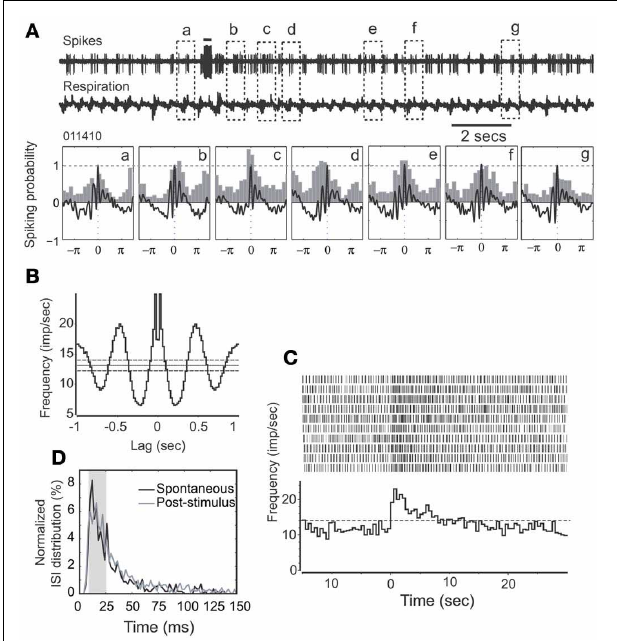
FIGURE 3 | HDB stimulation does not affect synchronization pattern of a rhythmically spiking unit. (A) Raw traces show spikes and respiration recorded simultaneously. Note that the unit remains synchronized with respiration following HDB stimulation. This unit has a long-lasting discharge activity. Lower panel: The respiration triggered spike histograms are shown before (a) or after stimulation (b–g). Respiration traces are averaged and 0 stands for the transition point between inhalation and exhalation. The top bar: electrical stimulation (100 μ s, 400 μ A, 100Hz, 25 pulses). (B) An autocorrelation analysis indicates the unit has a rhythmicity of 3Hz at a confidence limit of 99% (bin = 20ms). (C) Histogram and raster plot showing stimulation effects on mean spike rates. Note t = 0 indicates the beginning of NDB stimulation, and this applies to the rest of Figures. (D) Plot showing ISI distributions before or after stimulation, respectively. Note that ISIs following NDB stimulation are decreased ( p < 0 . 001).